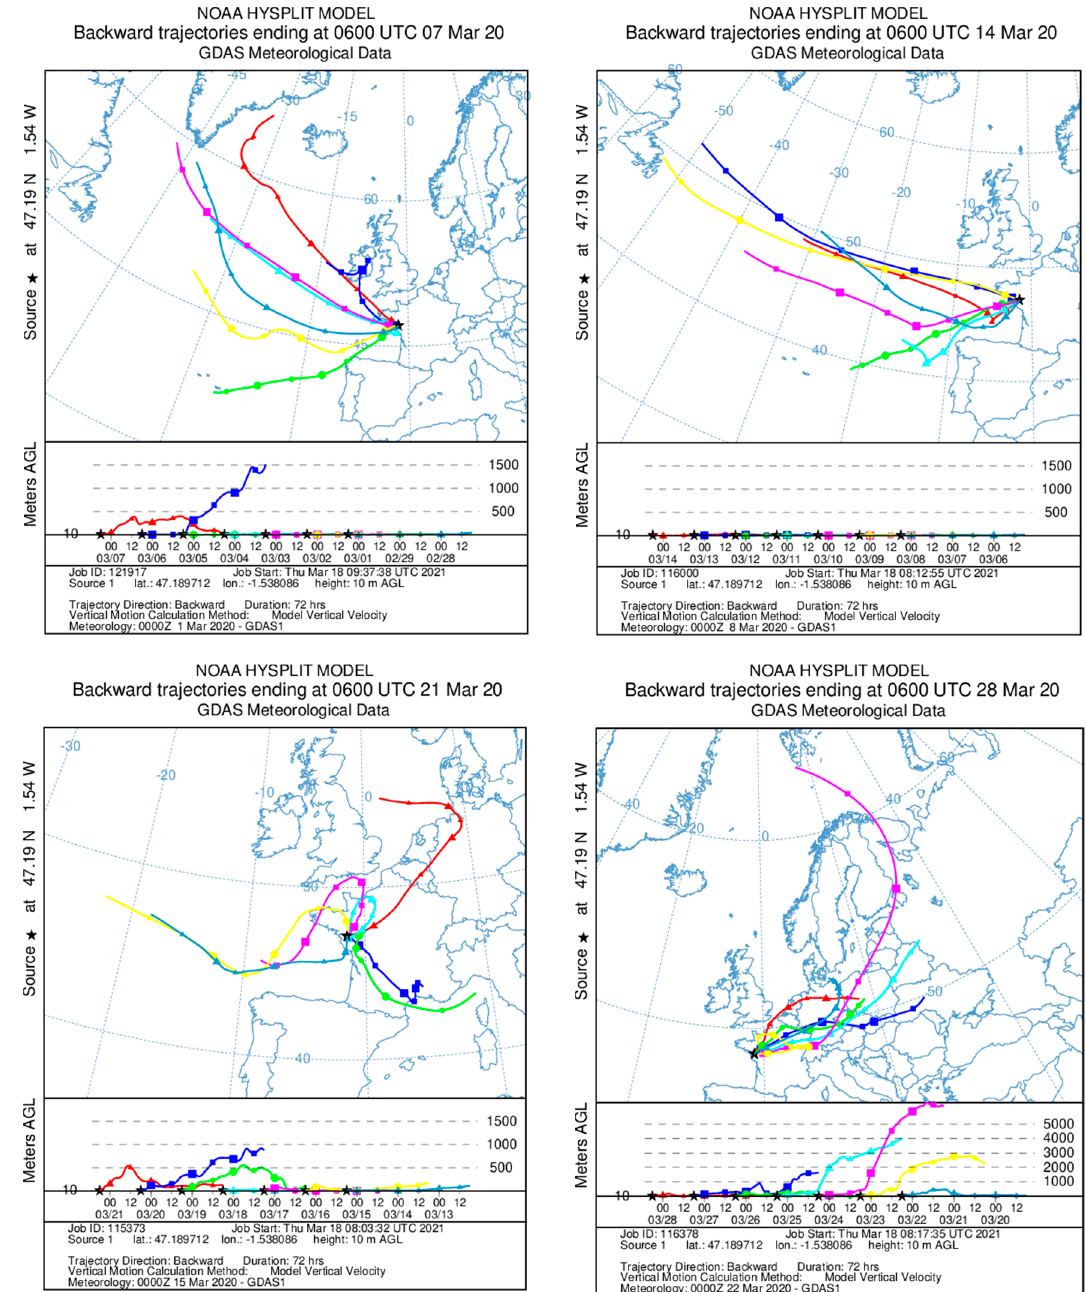
Figure 5. Calculated air mass back ‐ trajectories in Nantes (French Atlantic shoreline) for March 2020.